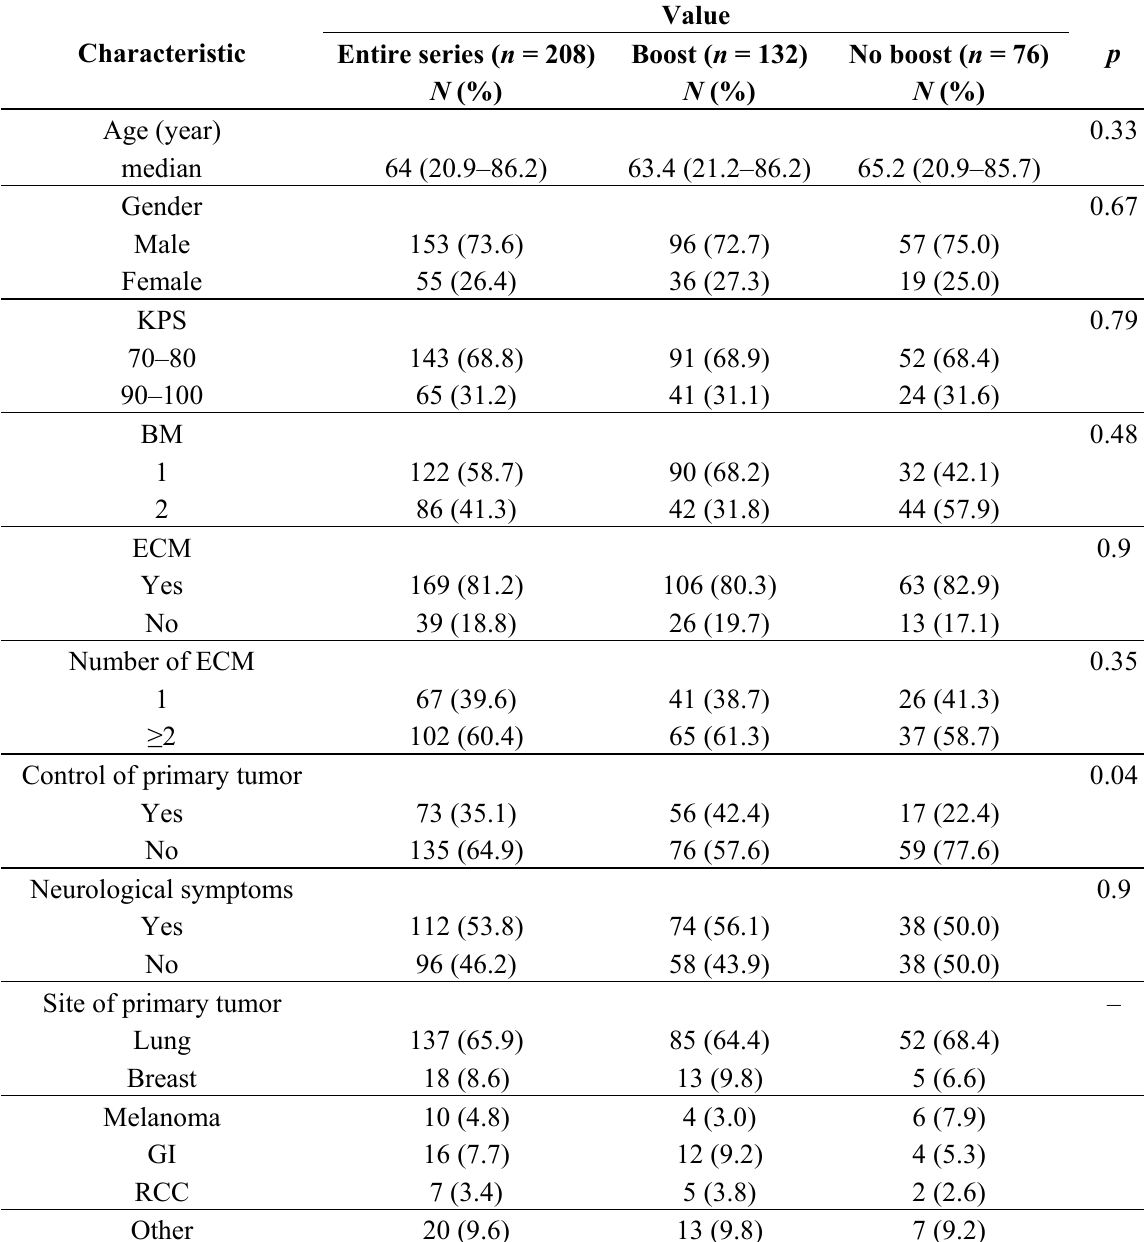
Table 3. Patient characteristics. KPS, Karnofsky Performance Status; BM, brain metastases; ECM, extracranial metastases; GI, gastrointestinal; RCC, renal cell cancer; N, patient’s